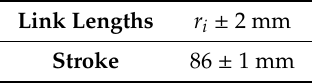
Table 5. Prescribed tolerances.